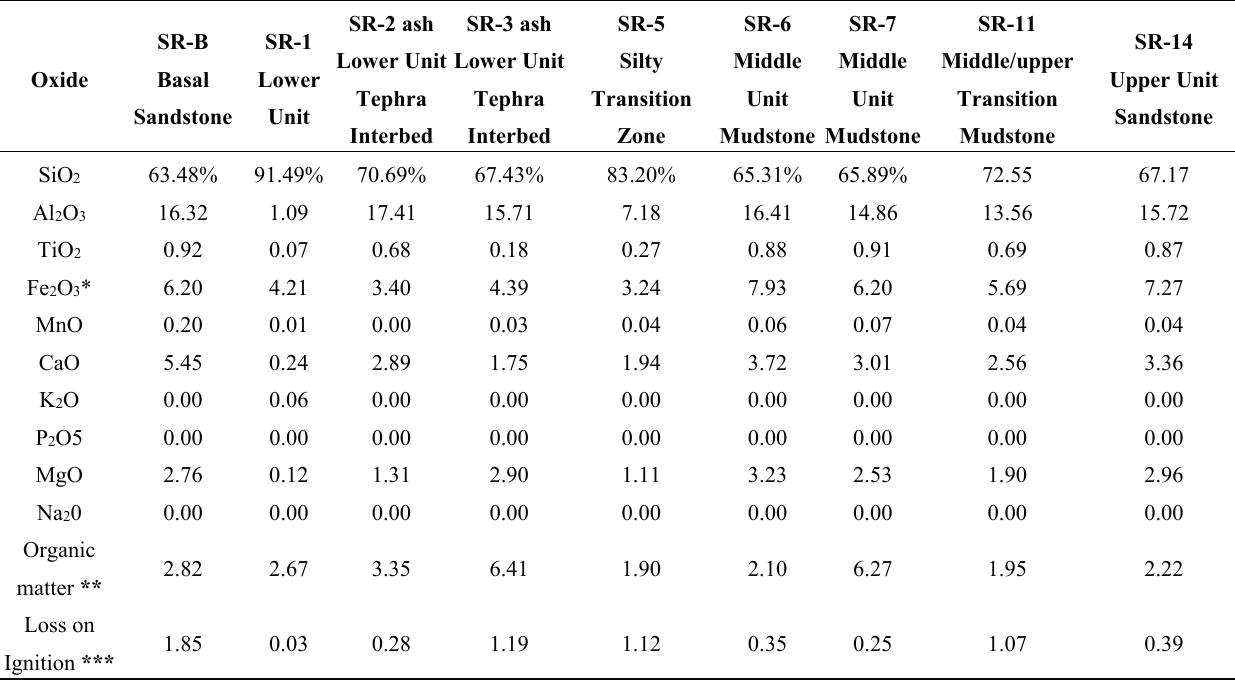
Table 1. Major element composition of samples from Stonerose Fossil Beds Boot Hill